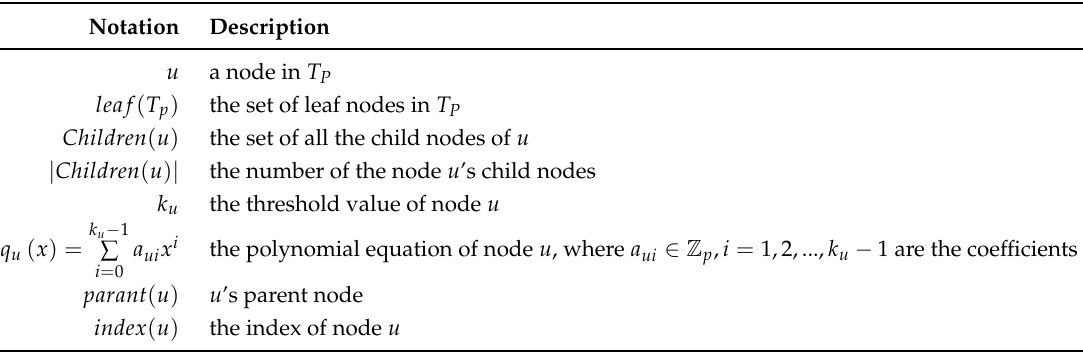
Table 1. The notations for access tree T P